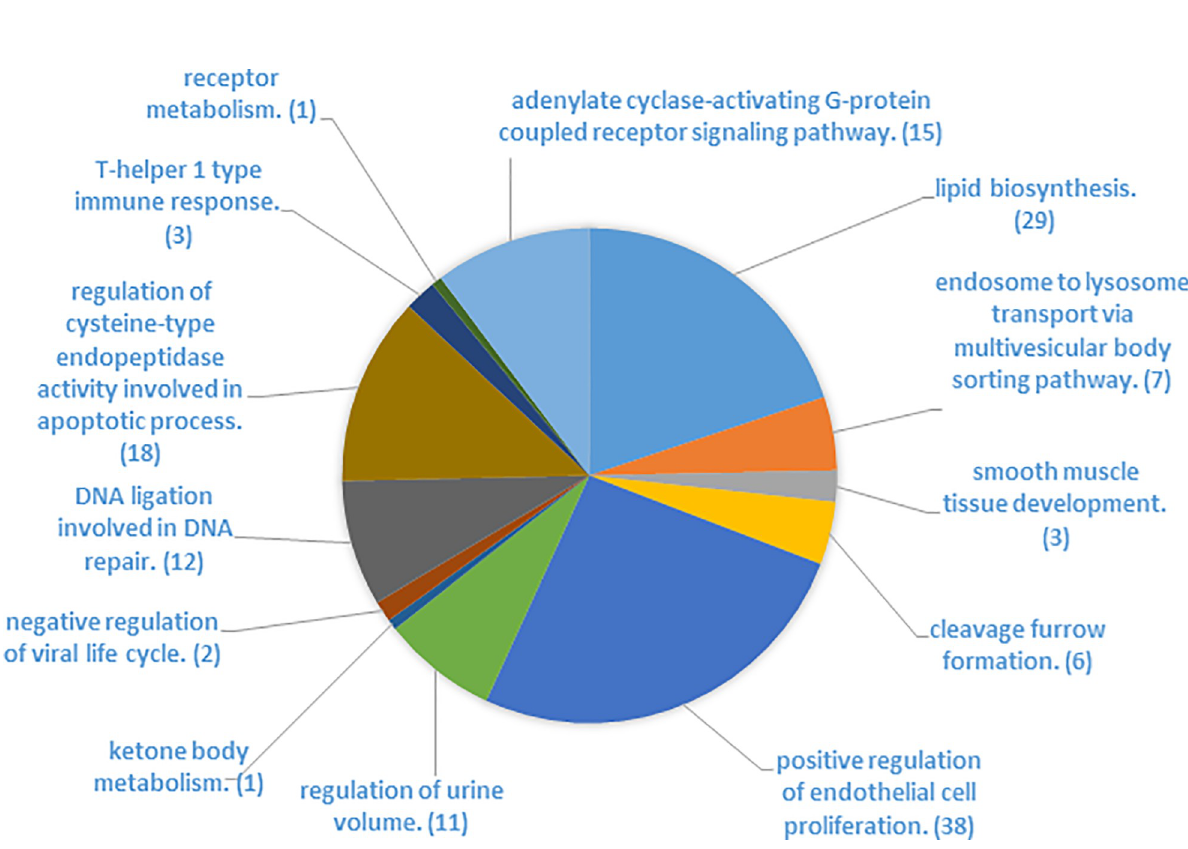
Fig 3. REVIGO categories obtained from the Enrichr biological process list using the 59 common mRNAs (P � 0.05). In brackets: Numbers of BPs in each category.